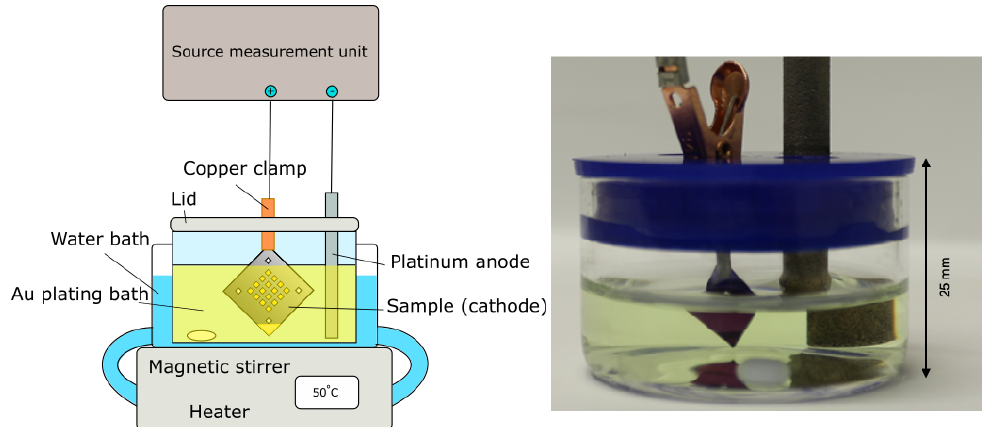
Figure 1. Picture of the experimental setup, indicating the size of the miniaturized bath, as well as a schematic of the full